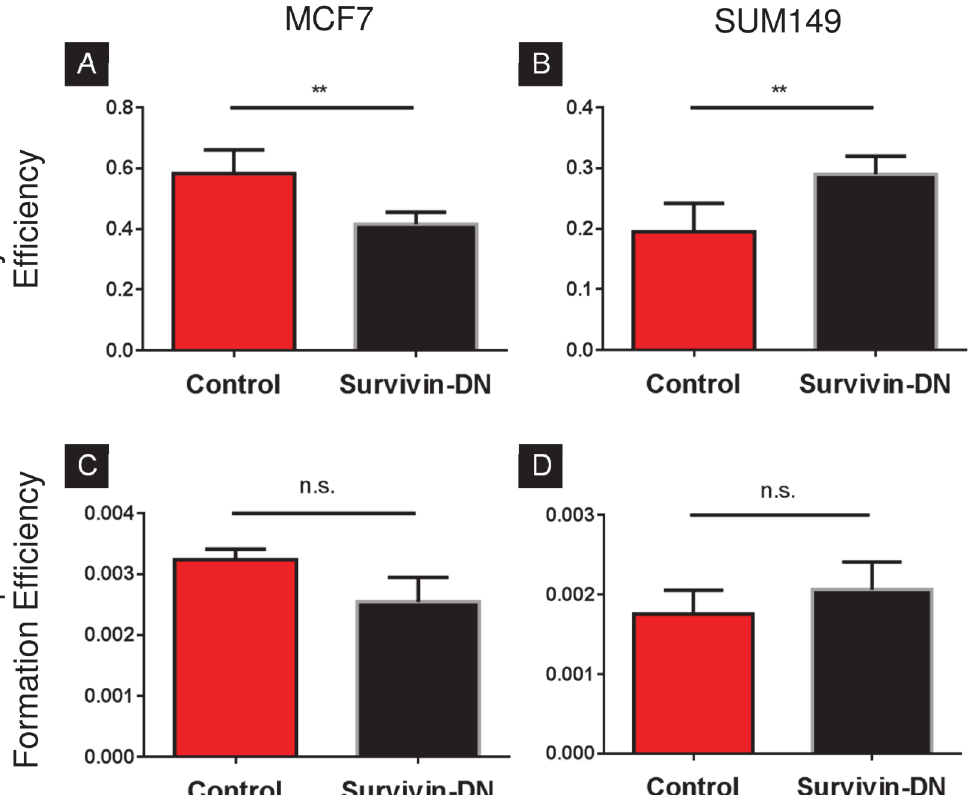
Fig 4. Colony- and mammosphere-formation efficiency in MCF7 and SUM149 breast cancer cell lines. A) In MCF7, the FUGW control forms significantly more colonies than the survivin-DN-transfected cells (p < 0.01). B) In SUM149, the survivin-DN cells form significantly more colonies than the control (p < 0.01). C,D) In both MCF7 and SUM149, there is no statistical difference in mammosphere-formation efficiency between the control and survivin- DN clone. Error bars indicate standard